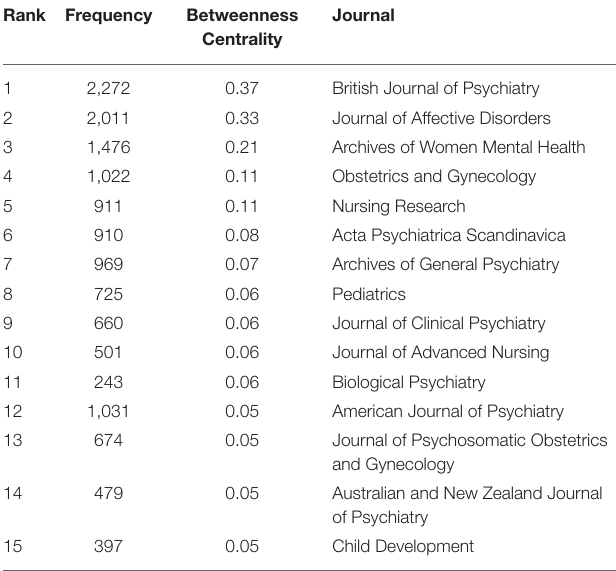
TABLE 2 | Ranking of the Top 15 cited-journals in the field of PPD by centrality from 2000 to 2020. Rank